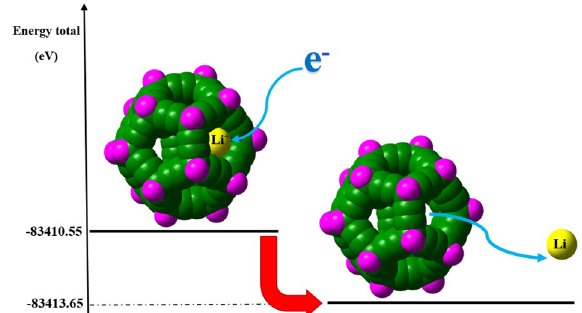
Figure 11. A schematic of the lithium atom inside the C 80 H 20 fulleryne cage. Our calculations shows that the lithium atom, like a hydrogen molecule, can move freely in the fulleryne cage, while the lithium ion is bound to the fulleryne cage, especially in its face. This feature makes the fulleryne cages susceptible to use as cathode/ anode electrodes in lithium-ion batteries.